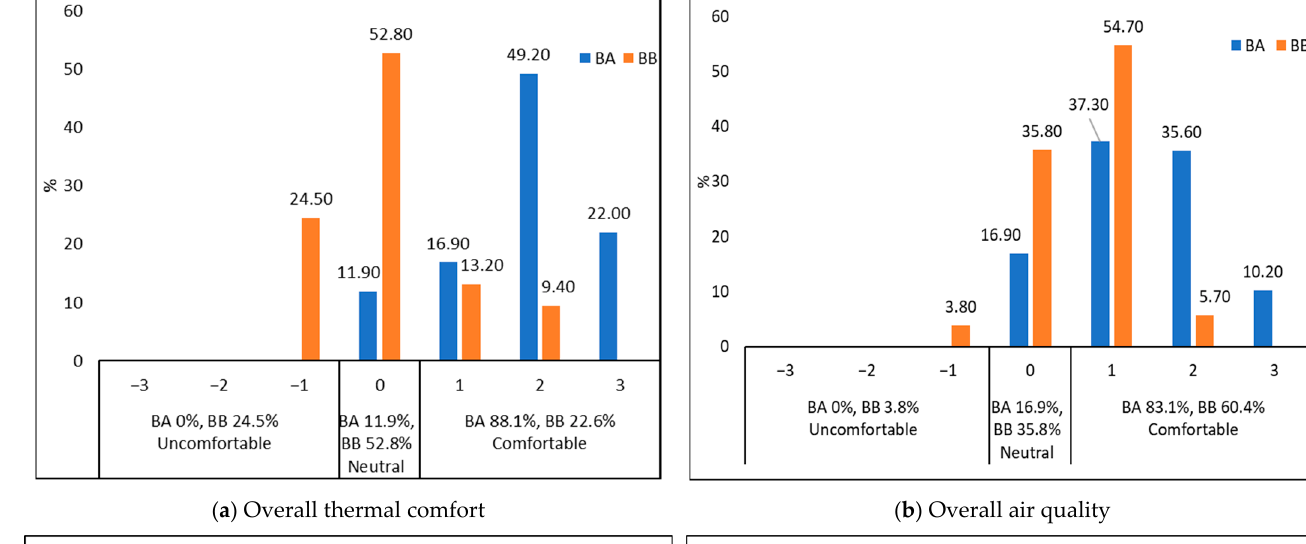
Figure 4. Frequency distribution of occupants’ vote for overall comfort.